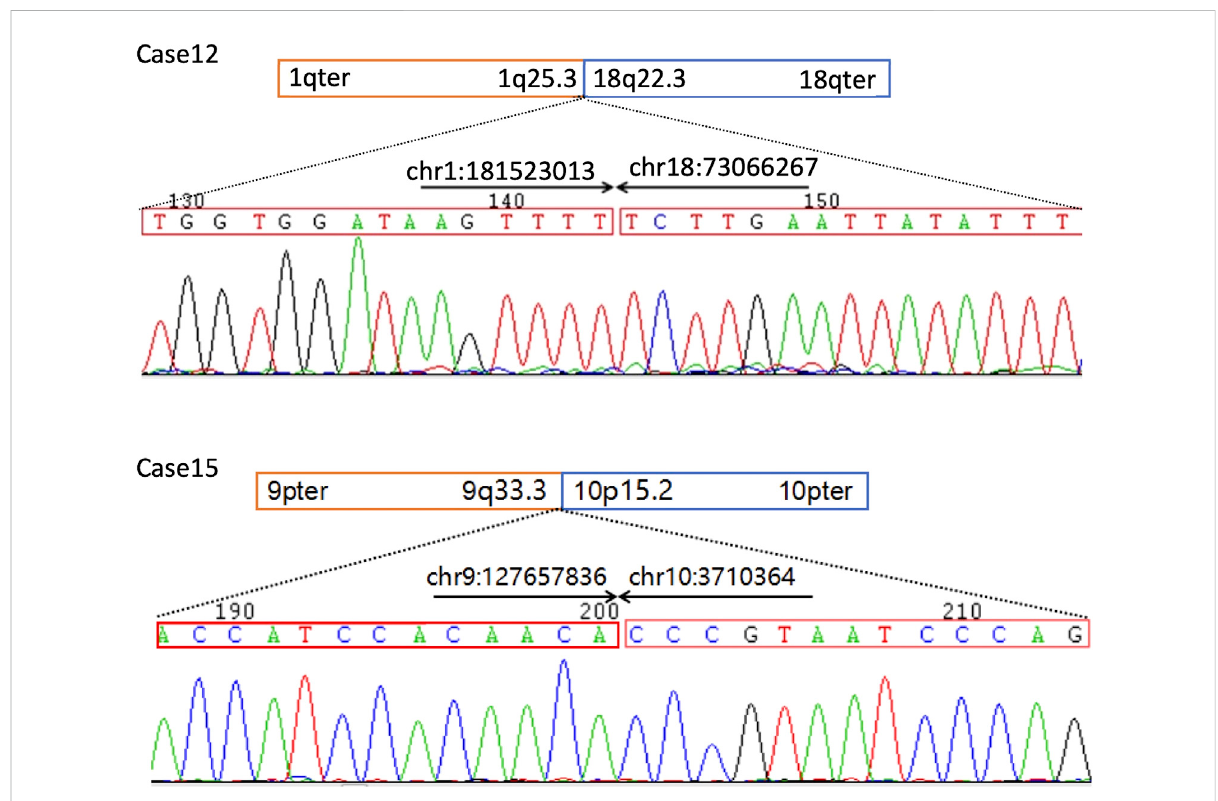
FIGURE 2 Sanger sequencing con fi rmation of the balanced chromosomal abnormalities (BCAs) breakpoints in Case 12 and 16. The comparison of sequencesdetectedbyWGSandSangersequencinginthecasesislistedinTable1.PCRprimersusedforSangersequencingasfollowing:Case12 F- TGGGAGGGATAAAGCGACTTG, R-CCTCCCATGACATGTAGGGATTAT, case 16 F-AACAGACTCTCCACAACAGAGAAC,